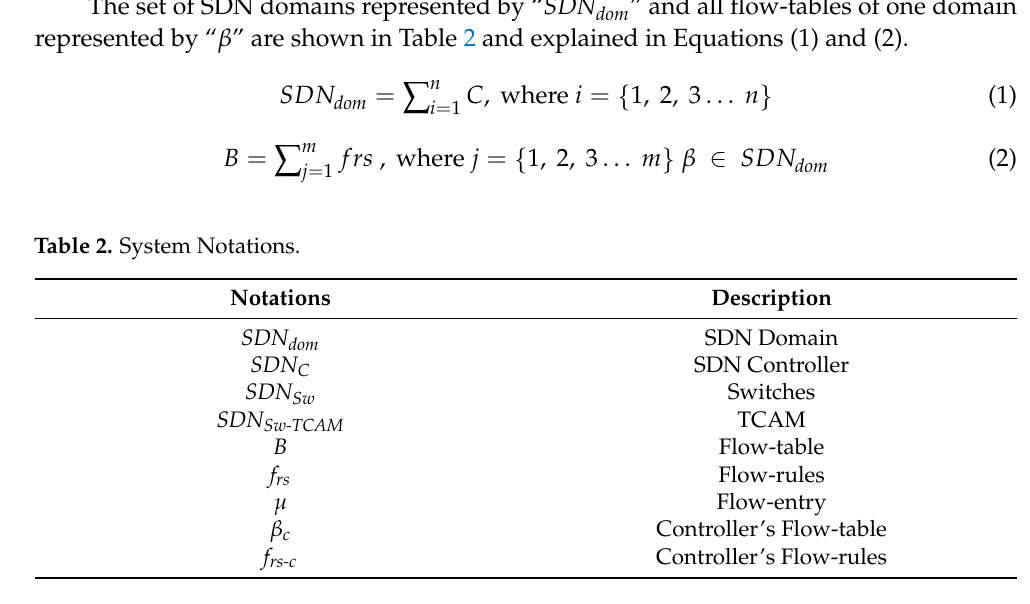
Table 2. System Notations